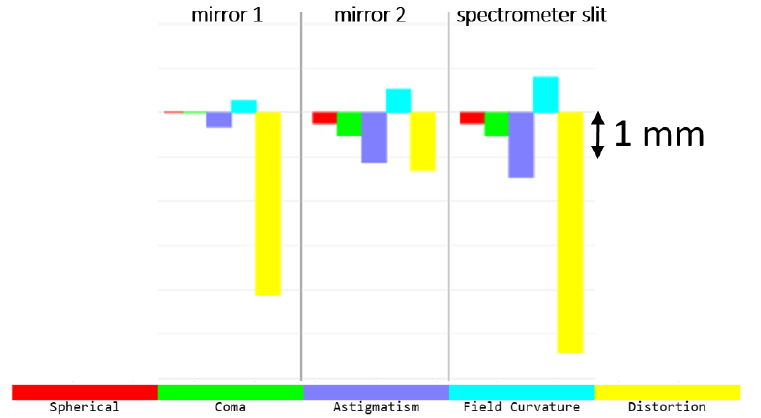
Figure 5. Contributions of the 5 Seidel aberrations. The largest aberration is the distortion, due to the large FOV. The aberrations are properly corrected, as the maximum scale is in the order of only 5 mm.